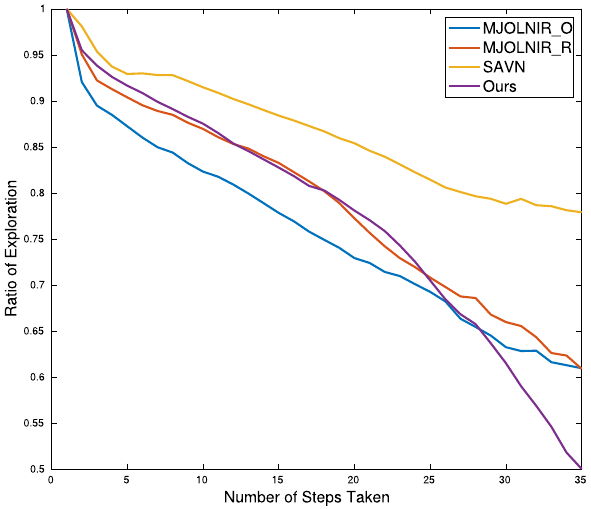
Fig.3 Ratioofexploration. Ourmethodhasalowerratioofexploration, which means our agent adopts more effective actions